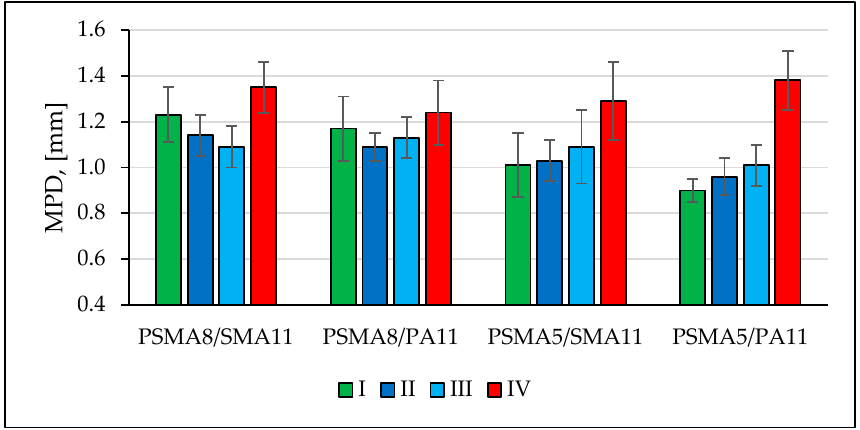
Figure 16. Results of macrotexture measurements on long test section in Kartoszyno.